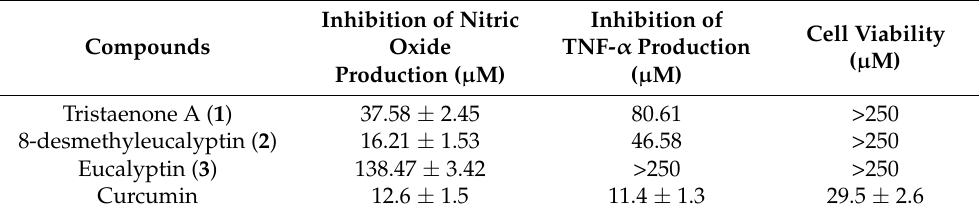
In addition, the effects of ( 1 ) on LPS and IFN- γ -induced expression of the pro- inflammatory cytokines TNF- α and IL-6 in macrophages were investigated. Tristaenone A ( 1 ) markedly decreased the production of TNF- α and IL-6 by showing IC 50 values of 80.6 ± 5.82 µ M and 125.65 ± 0.34 µ M, respectively. Additional investigations of ( 1 ) on NF- κ B translocation in LPS and IFN- γ -stimulated macrophages were performed to determine the mechanism underlying its anti-inflammatory effect. As expected, activation by the combination of LPS plus IFN- γ -induced NF- κ B accumulation in the nucleus of RAW 264.7 cells. This had been represented in (Figure 4), where the pre-treatment of cells with different concentrations of ( 1 ) (31.85, 63.70 and 127.41 µ M), significantly inhibited NF- κ B nuclear translocation by 52.93 ± 14.14%, 59.38 ± 15.99% and 100 ± 14.14%.